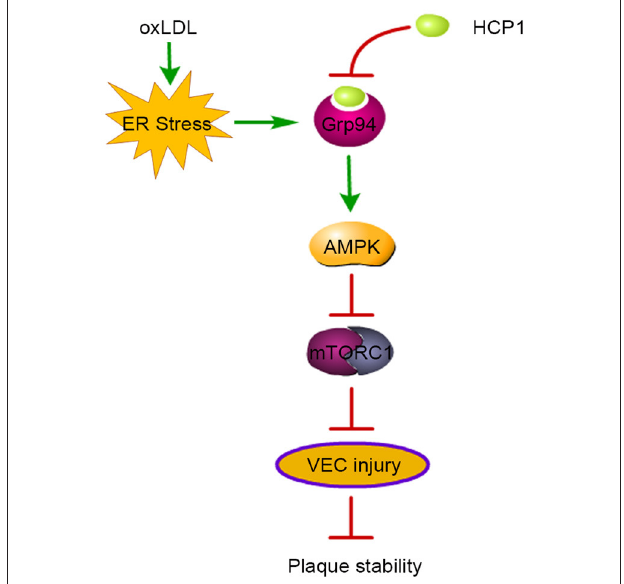
FIGURE 8 | Schematic diagram of HCP1-induced plaque stability in atherosclerosis. OxLDL induced Grp94 upregulation through ER stress and autophagy which leads to VEC injury and plaque instability in apoE − / − mice. Grp94 inhibitor HCP1 suppressed oxLDL-induced autophagy